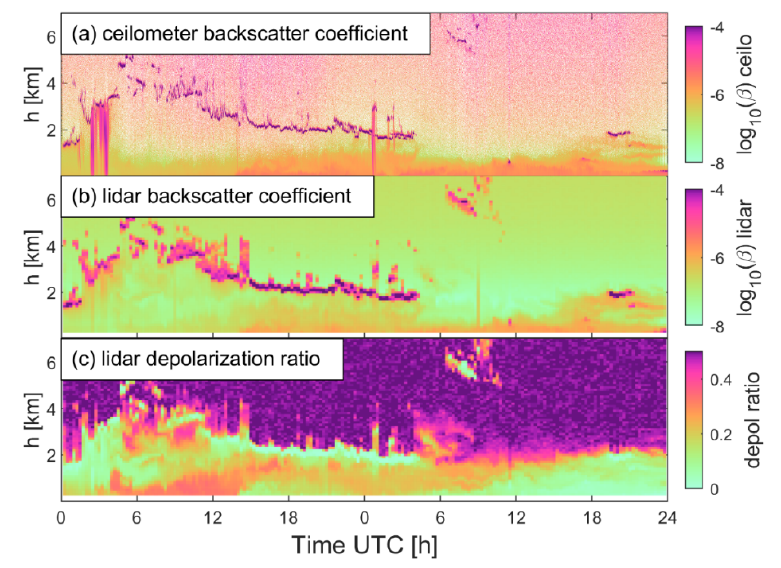
Figure 13. Time height cross-section of the backscatter coefficient from the ceilometer ( a ) and the Doppler lidar ( b ) as well as the lidar depolarization ratio ( c ) in Reykjavik, for 48 h, from 00:00 UTC, 31 July to 24:00 UTC, 1 August 2019. The lidar data is an average of 15 min. Note that the lidar measurements start at 200 m above the surface.